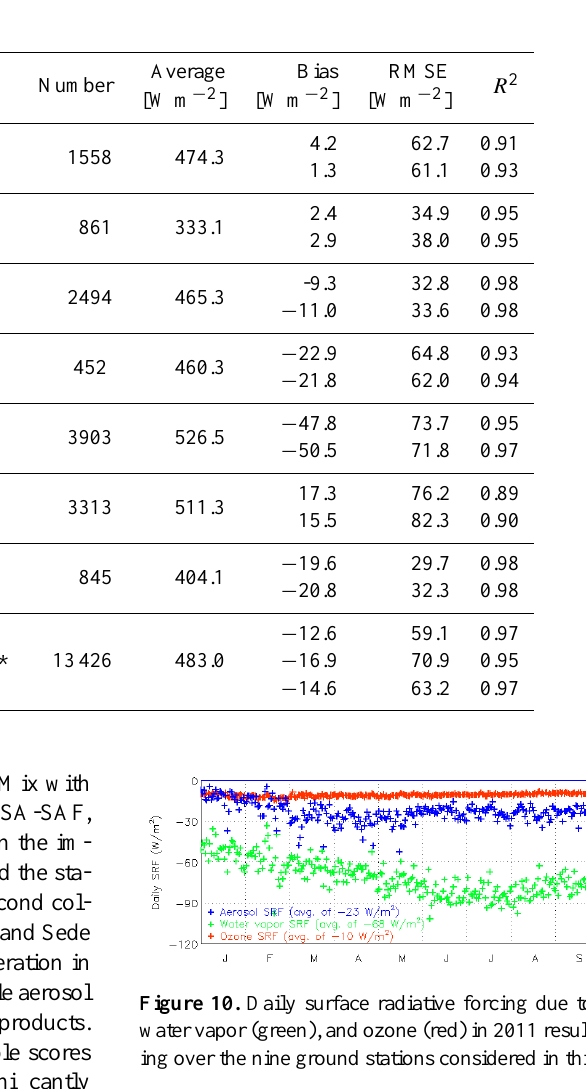
Table 4. Accuracy scores for instantaneous values of direct DSSF estimated by SIRAMix for all clear-sky instantaneous instants of time at 00 or 30min and the nine ground stations in 2011. Ground measurements are used as reference. Results from the LSA-SAF and McClear products are also shown for comparison. Measurements of direct DSSF are not available for stations in Evora and Granada. For this experi-